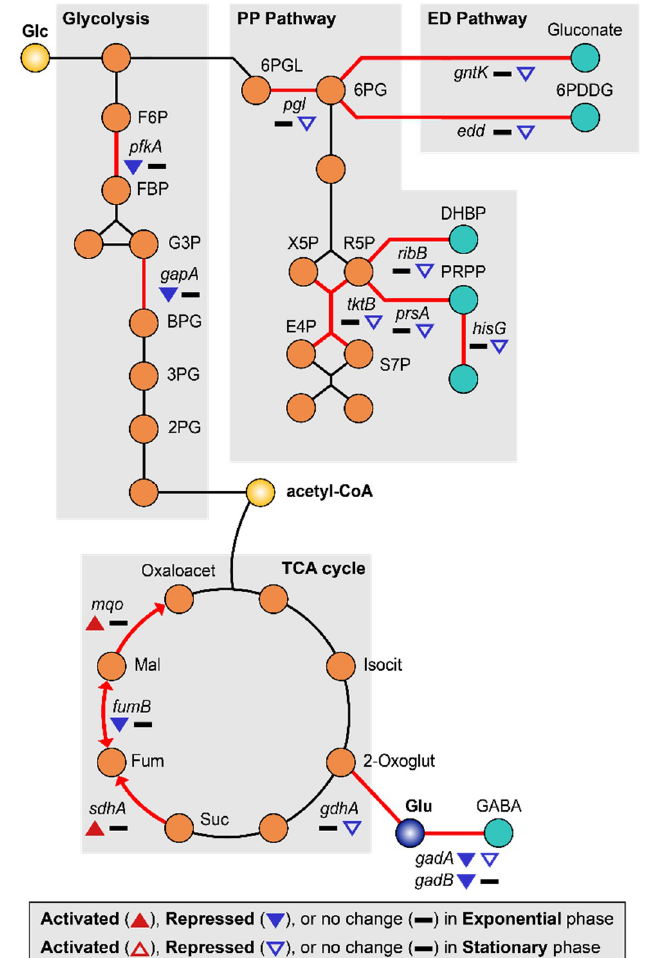
Figure 5. DEGs related to carbon starvation metabolism are shown. The up-regulated and down- regulated genes under the MG condition compared to the NG condition are depicted by the direction of the up and down arrowheads, respectively. DEGs during the exponential and the stationary growth phases are indicated by the solid and empty arrowheads, respectively.